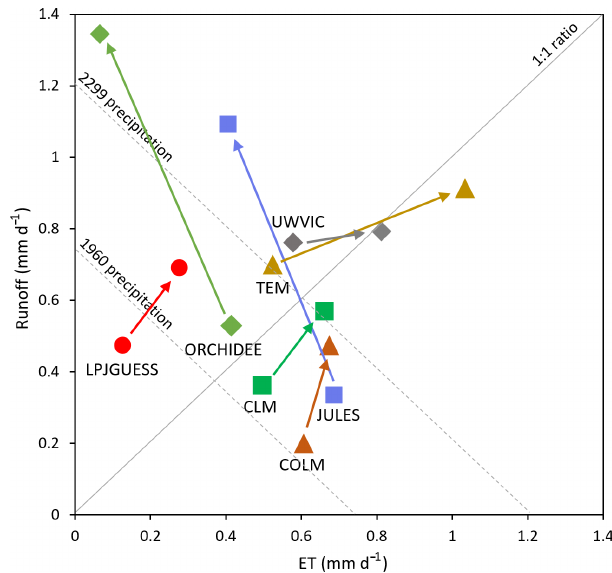
Figure 5. Precipitation partitioning between total runoff and evapo- transpiration for participating models. Markers and arrows indicate the change from initial period (1960–1989 average) to final period (2270–2299 average). Diagonal dashed lines represent the ensemble rainfall mean for the initial (0.74mmd − 1 ) and final (1.2mmd − 1 ) simulation years. At any point along the dashed diagonals, runoff and ET sum to precipitation.